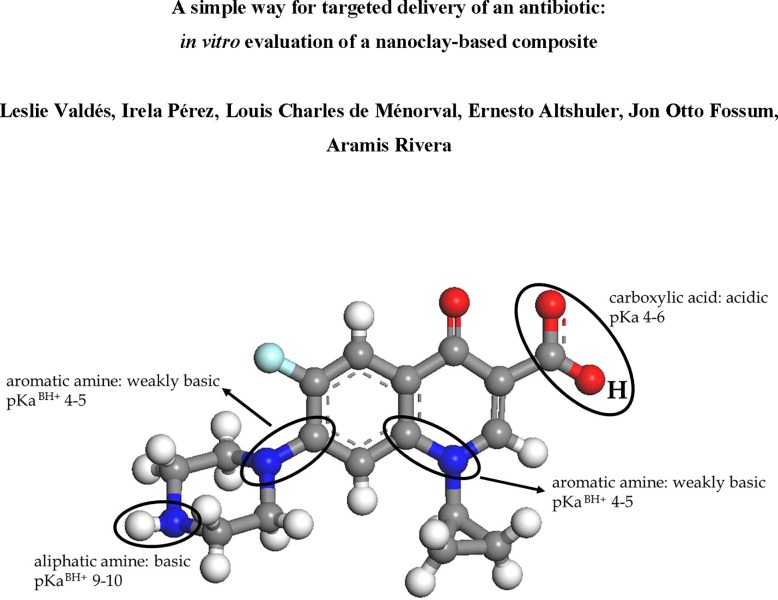
Molecular structure of the ciprofloxacin, and estimated pKa values of the different functional groups—BH+ is referred to their degree ionization.